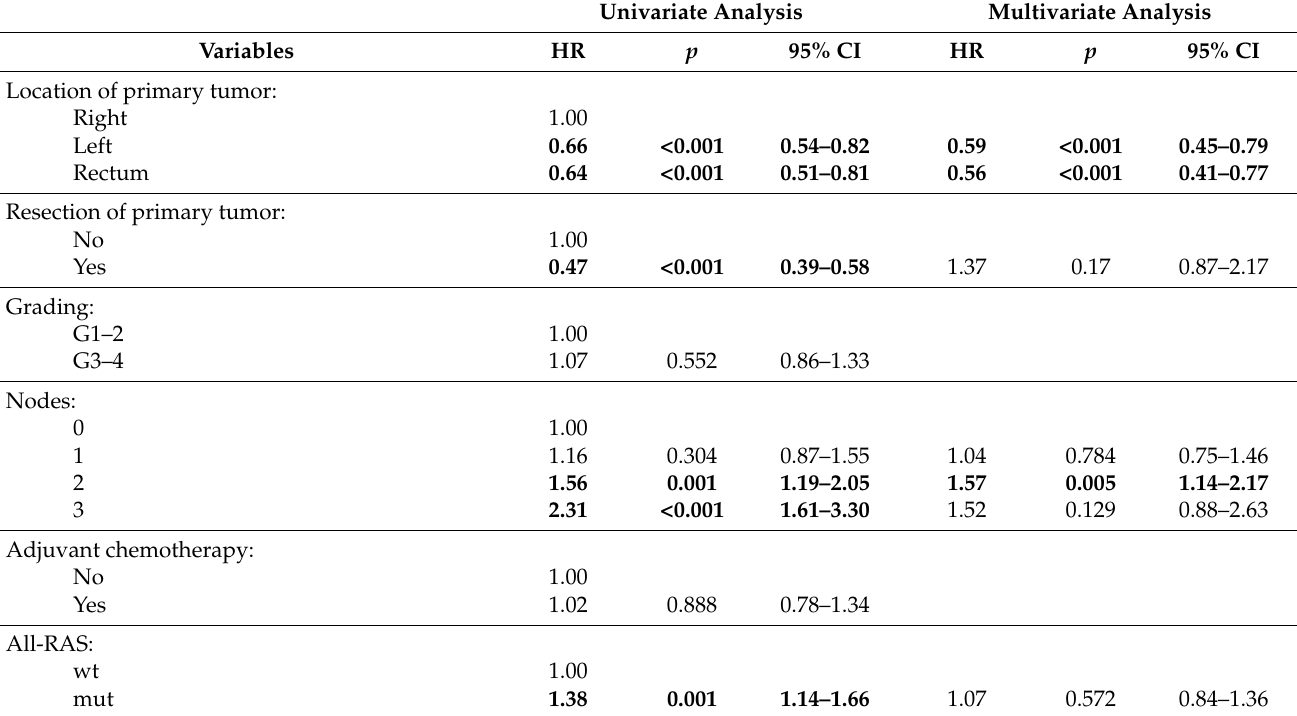
Table 2. Univariate and multivariate analyses for OS. Significant associations are written in